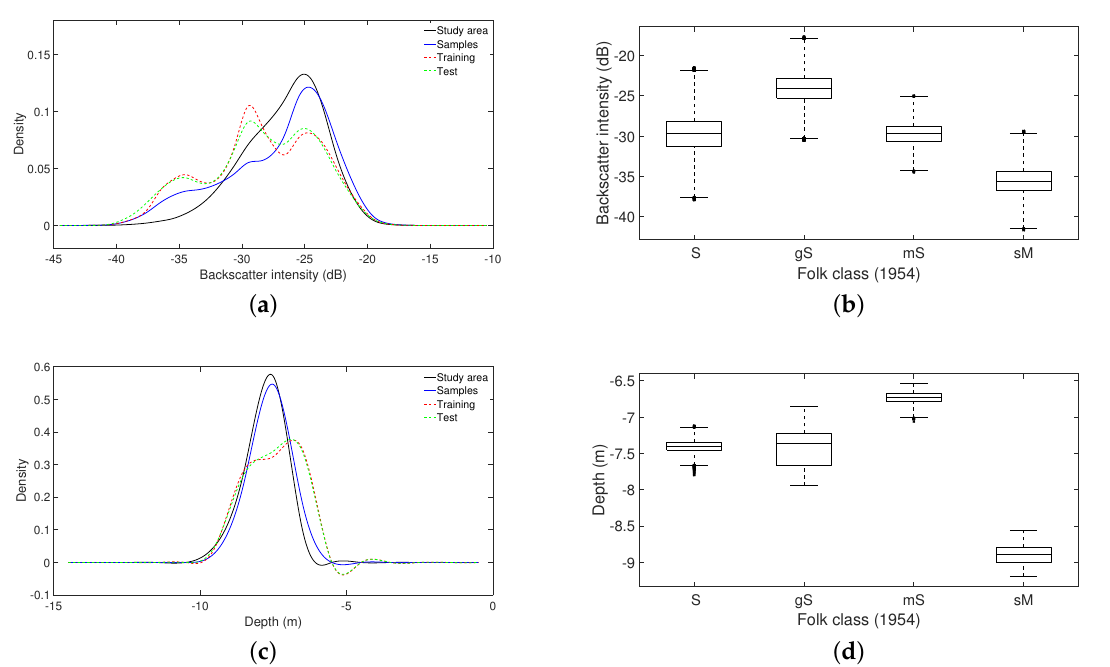
Figure 4. ( a ) Backscatter distribution in the study area and per sample dataset, ( b ) boxplot of the backscatter for each type of sediment; ( c ) depth distribution in the study area and per sample dataset; ( d ) boxplot of the depth for each type of